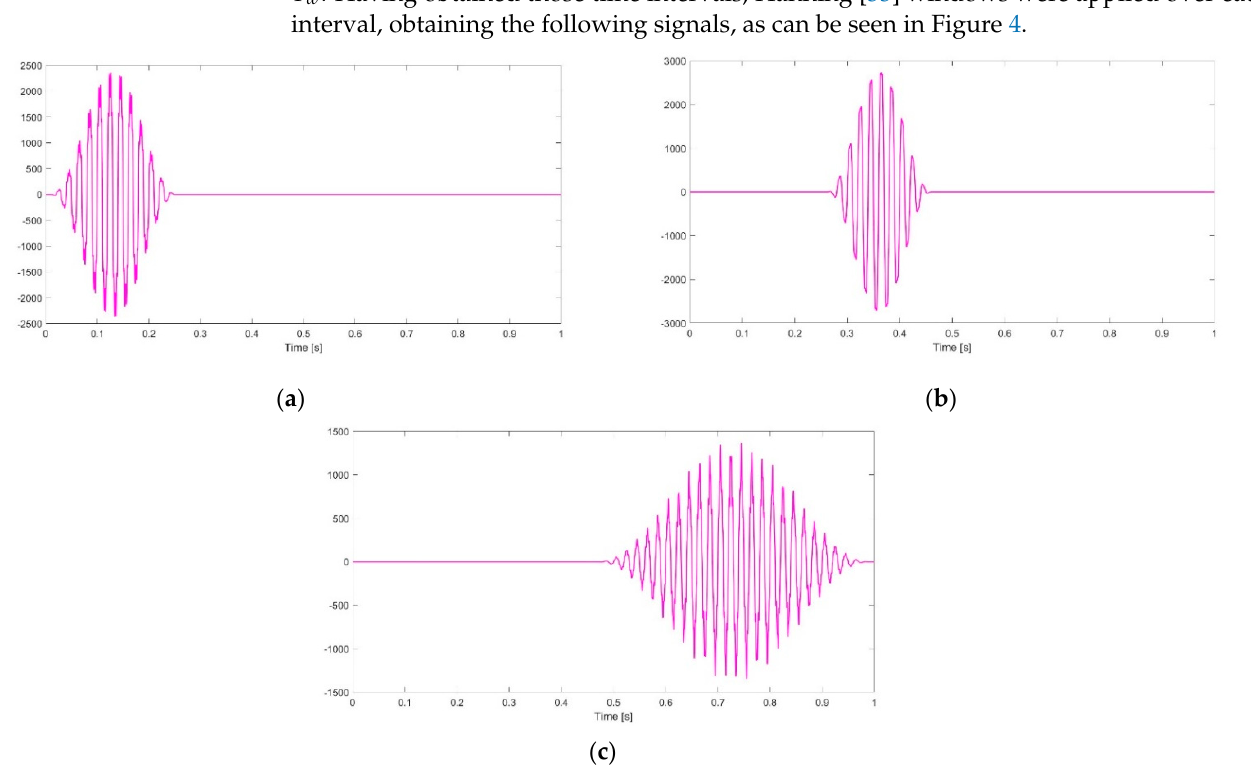
Figure 3. ( a ) Original digitized signal described in Table 1, ( b ) Discrete Fourier Transform (DFT) spectrum of the original signal-range 100 Hz to 550 Hz.